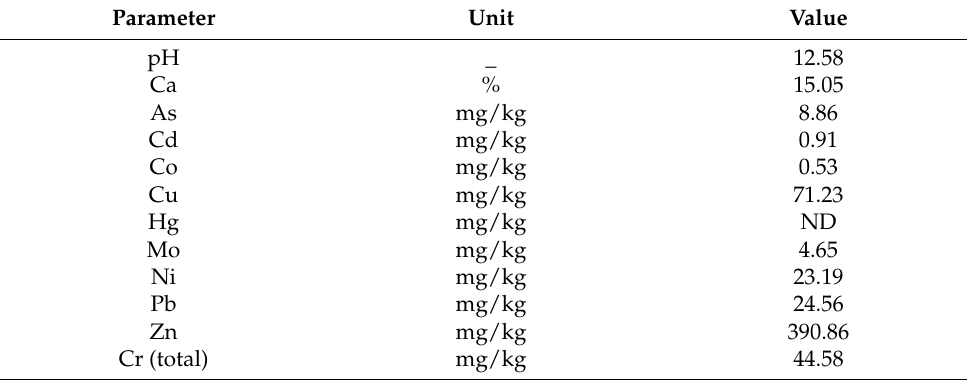
Table 2. Physicochemical characterization of SS.